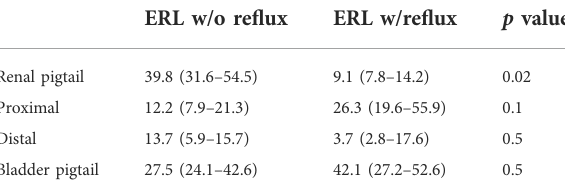
TABLE 2 Median ERL (IQR) from each encrustation test